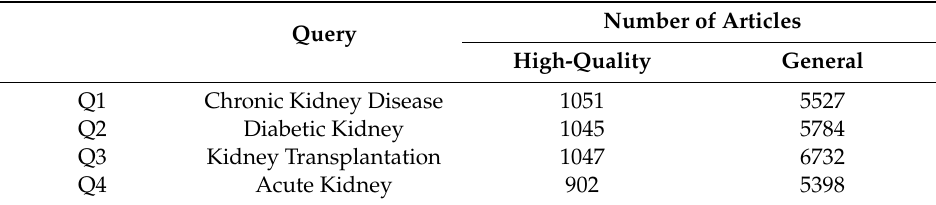
Table 4. Same domain test queries and number of articles.